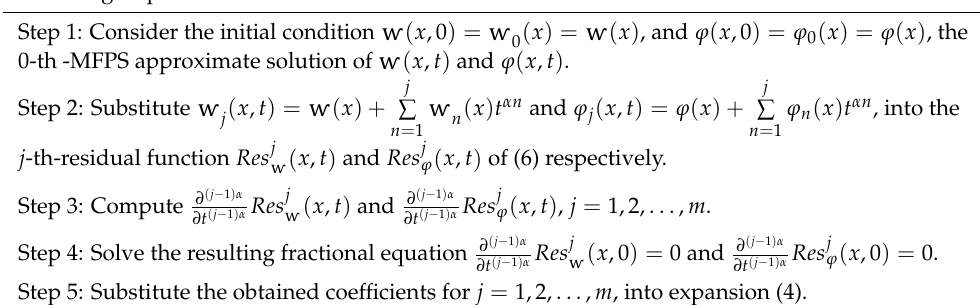
Algorithm 1. To find out the